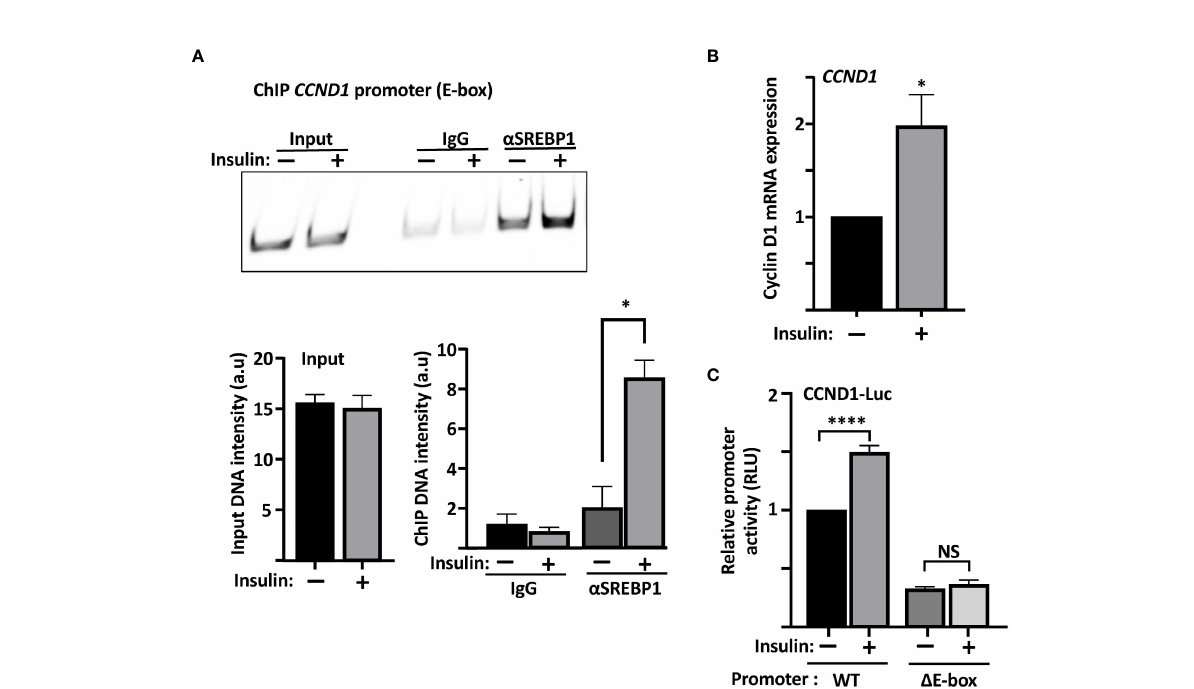
FIGURE 5 The recruitment of SREBP1 to the cyclin D1 promoter correlates with enhanced expression of the cyclin D1 gene. (A) MCF7 cells were serum starved for 24 h and then left untreated or treated with insulin for an additional 2 h. The cells were collected, permeabilized, incubated with SREBP1 or preimmune rabbit (IgG) antibodies, followed by the protein A/G-MNase fusion protein. Endogenous SREBP1 and its bound DNA was subsequently isolated using protein A magnetic beads and used for PCR with primers speci fi c for the E-box in the human cyclin D1 promoter. The same primers were also used for PCR of the same region from genomic DNA isolated from the same cells ( Input ). The PCR products were separated on PAGE gels and stained with SYBR Safe ( upper panel ). The intensity of the signals in the samples and the input were quanti fi ed ( lower panel ). (B) mRNA was isolated from the cells in (A) and used to determine the expression of cyclin D1 by real-time qPCR, using GAPDH as a reference. (C) MCF7 cells were transfected with the CCND1-luc promoter – reporter gene, either wild-type ( WT ) or the D E-box, serum starved for 24 h followed by an additional 2-h incubation in the absence or presence of insulin, after which the cells were lysed, and luciferase activity was measured. Signi fi cance was determined by paired t-tests (A – C) . p-values lower than 0.05 were considered statistically signi fi cant. *p < 0.05, **p < 0.01, ***p < 0.001, and ****p< 0.0001. NS , not signi fi